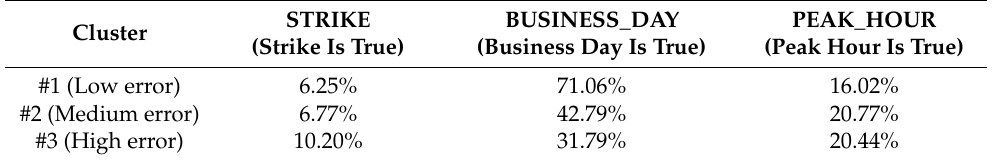
Table 7. Percentage of frequency of observations of the categorical variables within the formed clusters. STRIKE BUSINESS_DAY Cluster (Strike Is True) (Business Day Is